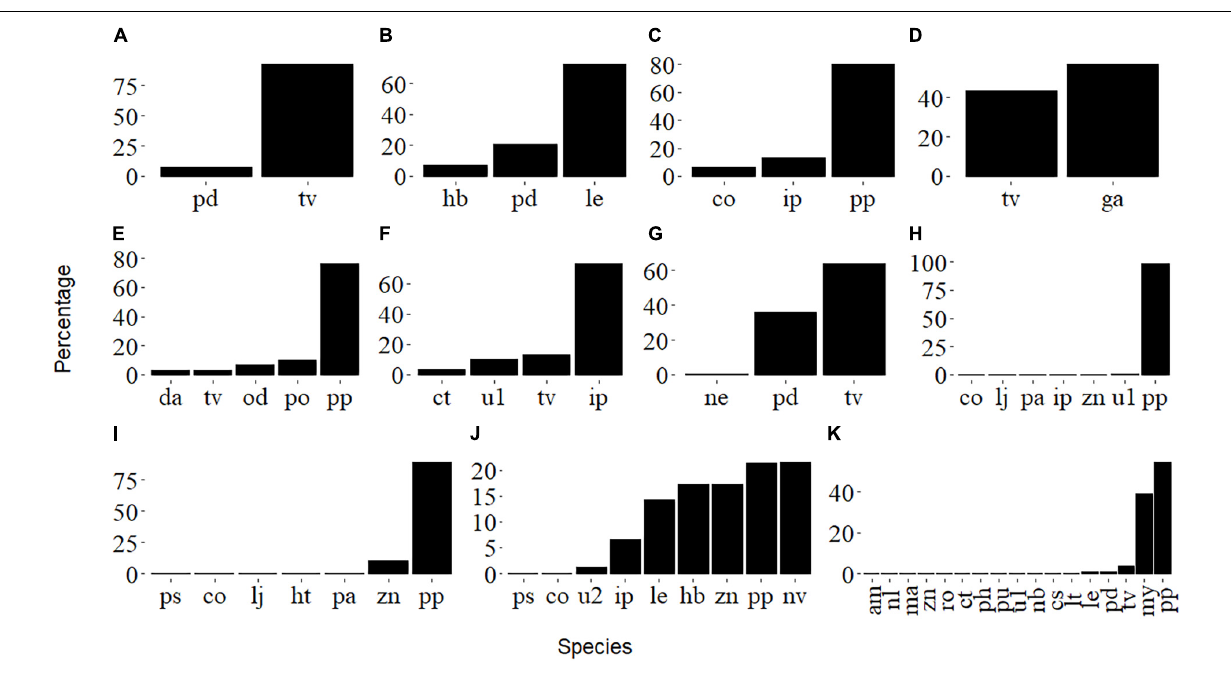
(Wickham et al., 2019) were used for data analysis. All statistical analyses were performed with R 4.1.0 (R Core Team,